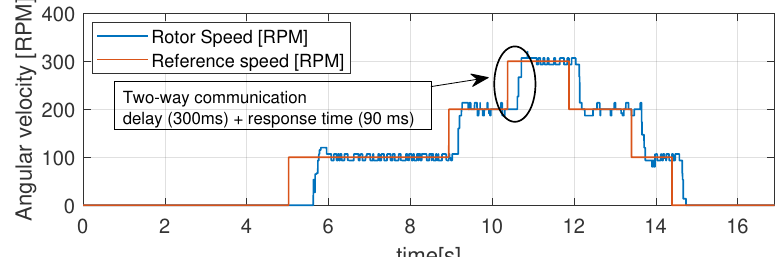
Figure 8. Rotor speed (experimental test II).